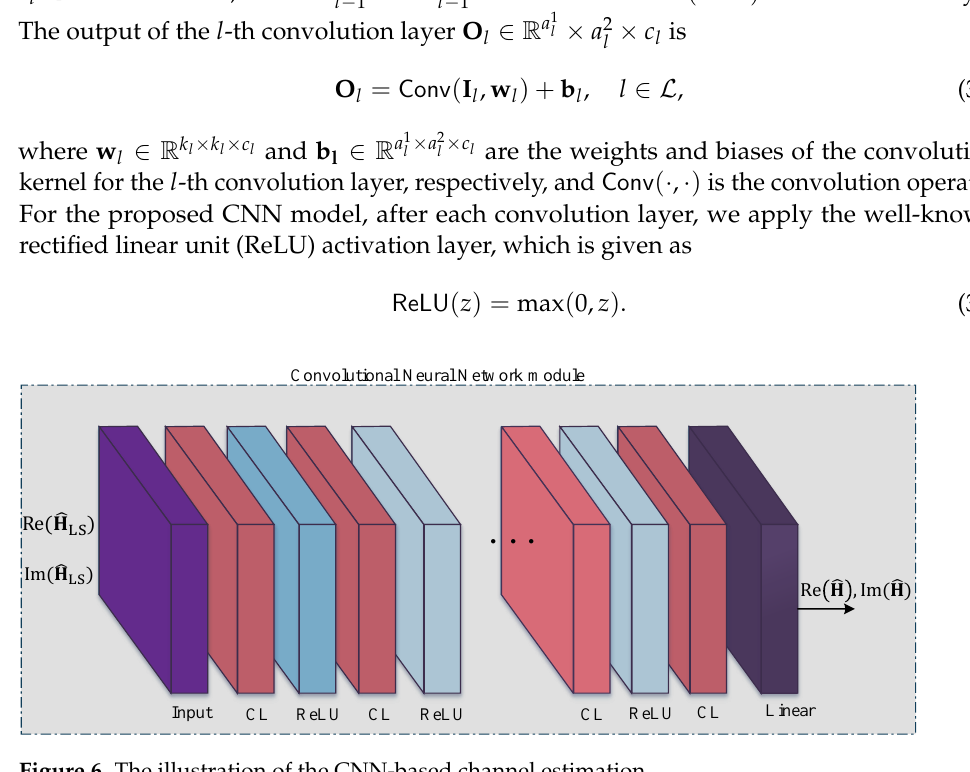
Figure 6. The illustration of the CNN-based channel